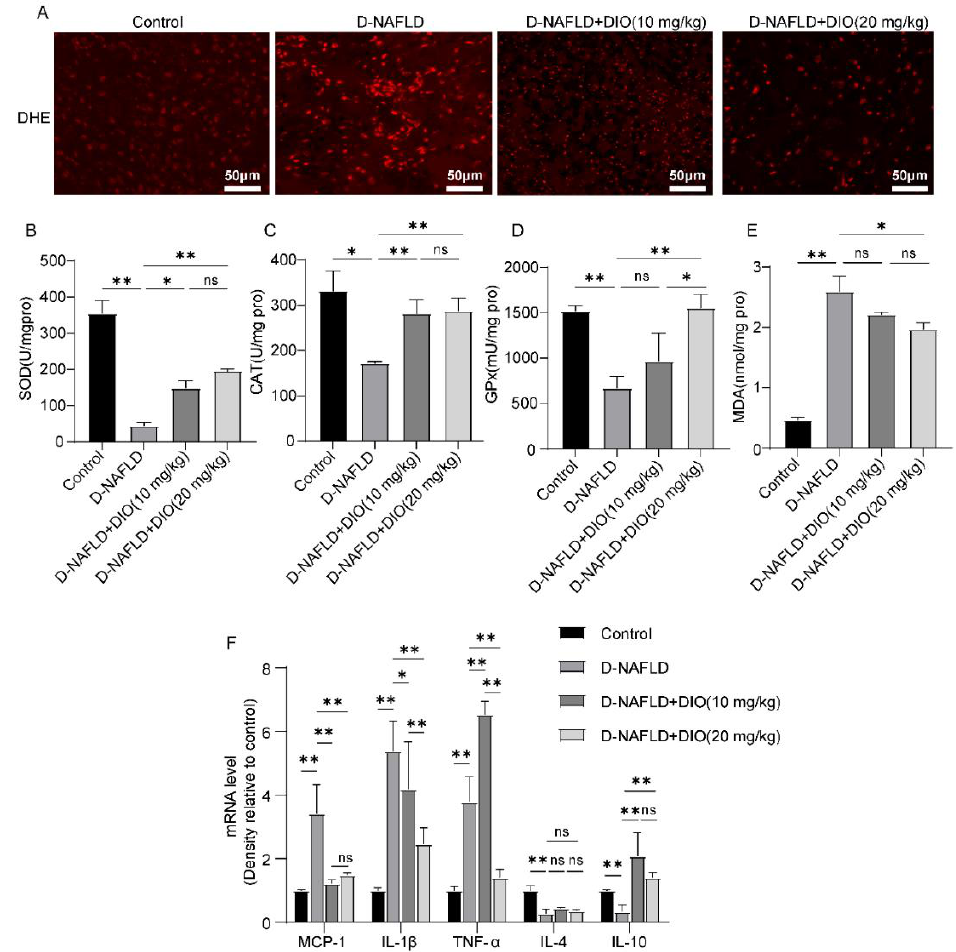
Figure 6. DIO ameliorated oxidative stress and inflammation in the liver of D-NAFLD rats. ( A ) DHE fluorescence, ×200, scale bars = 50 µm. ( B ) SOD level. ( C ) CAT level. ( D ) GPx level. ( E ) MDA level. ( F ) The mRNA expressions of MCP-1 , IL-1 β , TNF- α , IL-4 and IL-10 . Data in ( A ) ( n = 3) and data in ( B – F ) ( n = 5) were presented as mean ± SD. ns indicates no significance, * and ** indicate significant difference and highly significant difference, respectively.